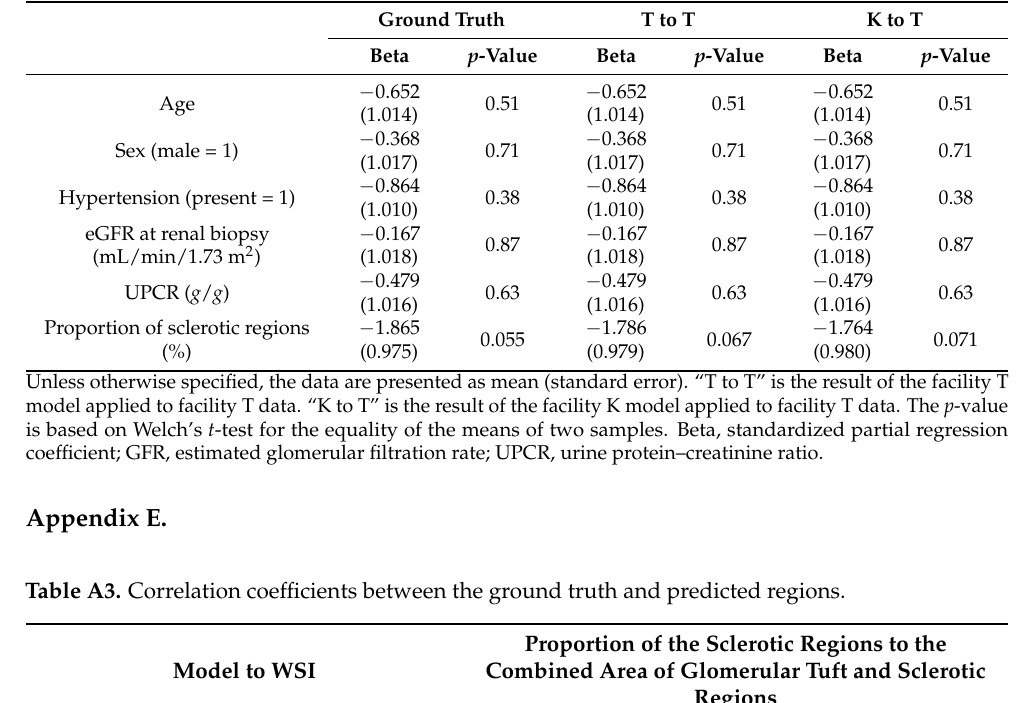
Table A2. Results of the univariate regression analysis.